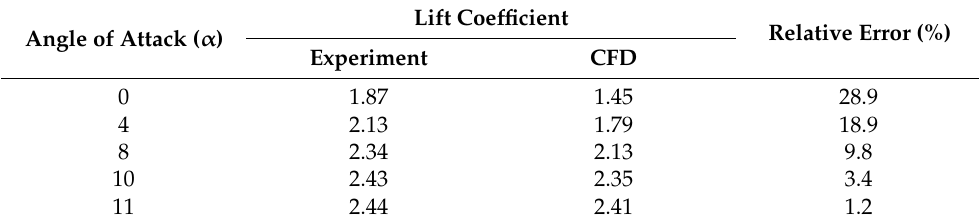
Figure 8. Validation of numerical results for pressure coefficient using experimental data (Melton et al. [18]) for the NACA 0015 airfoil with a flap and fluidic oscillators (x 0 /c = 0.7, α = 8°, δ f = 40° and y/s = 0.5) performed by Kim and Kim [29]. ( a ) Case I and ( b ) Case II. Table 4. Validation of numerical results for lift coefficient using experimental data (Melton et al. [18]) for the NACA 0015 airfoil with a flap and fluidic oscillators (x 0 /c = 0.7, C μ = 2.15%, α = 8°, δ f =